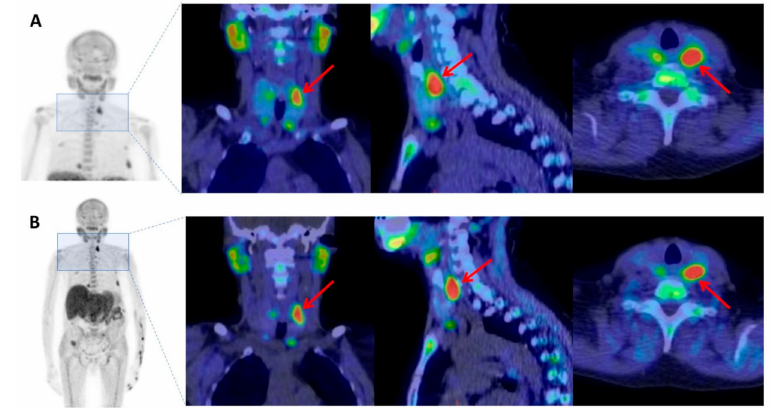
Figure 3. 18 F-FCH PET / CT was performed as the last preoperative imaging. ( A ) A static image acquisition was started 5 min after injection of 2.5 MBq / Kg of 18 F-FCH from the skull to the diaphragm in order to include any ectopic foci, based on the literature evidence [5,6]. ( B ) A late acquisition at 60 min was subsequently performed, choosing a whole-body protocol because of the evidence of 18 F-FCH uptake in bones in the early scan. PET / CT clearly showed 18 F-FCH uptake in the four parathyroid glands, particularly in the left superior one that appeared also enlarged (red